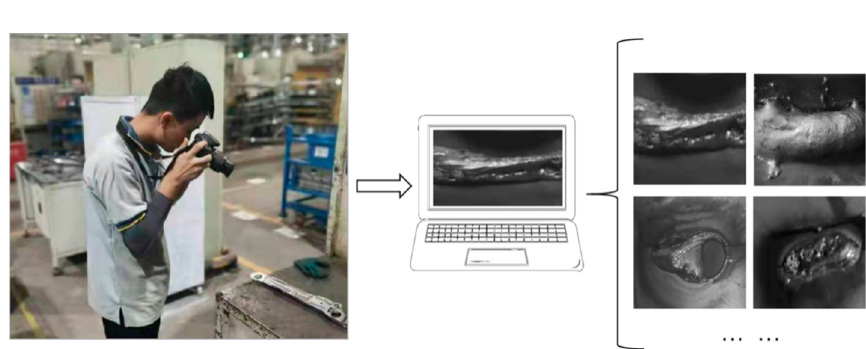
Figure 5. Image acquisition.